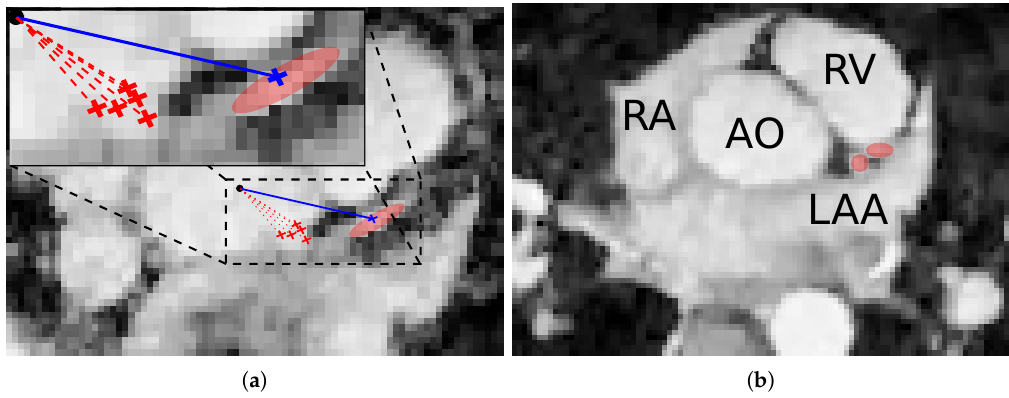
Figure 7. Problems that are occurring in the course of the centerline extraction. ( a ) Early detection of the coronary ostia. The slice shows the closest visible cross section of the LCA to the aorta. The detected ostium is marked in blue and the expert annotated ostia are marked by red crosses. ( b ) An example of the interference of the left coronary artery with the left atrial appendage. The LCA’s branches are marked in